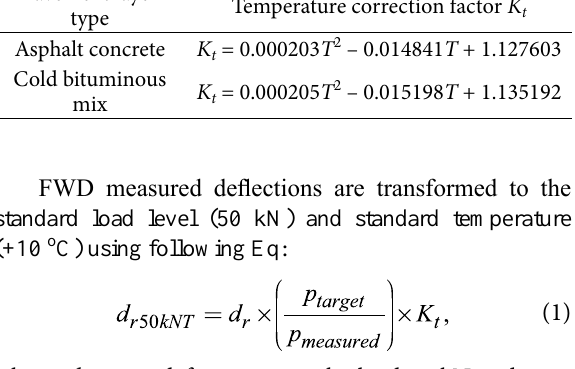
Table 3. Bituminous pavement layer temperature correction factors K t (Aavik 2003) Pavement layer